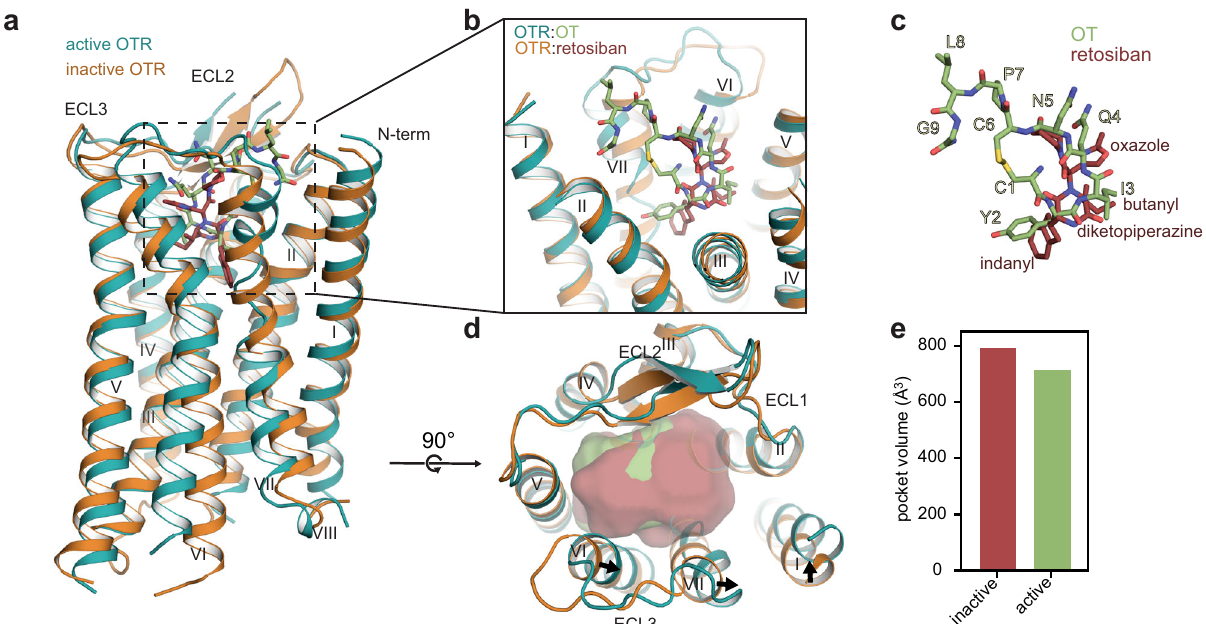
Fig. 2 Ligand-induced changes in OTR activation. a Superposition of active OTR:OT complex (teal) and inactive OTR:retosiban complex (orange, PDB ID: 6TPK). b Close-up on binding pockets of OT and retosiban viewed from the extracellular side. c OT and retosiban binding modes as viewed from the membrane plane. d Extracellular view of the super-positioned receptors with calculated pocket volume shown as surface representation. Arrows indicate shifts of the extracellular helix tips from inactive to active state. e Calculated pocket volumes for inactive and active OTR conformations. Pocket volumes were calculated with POVME 2.0 42